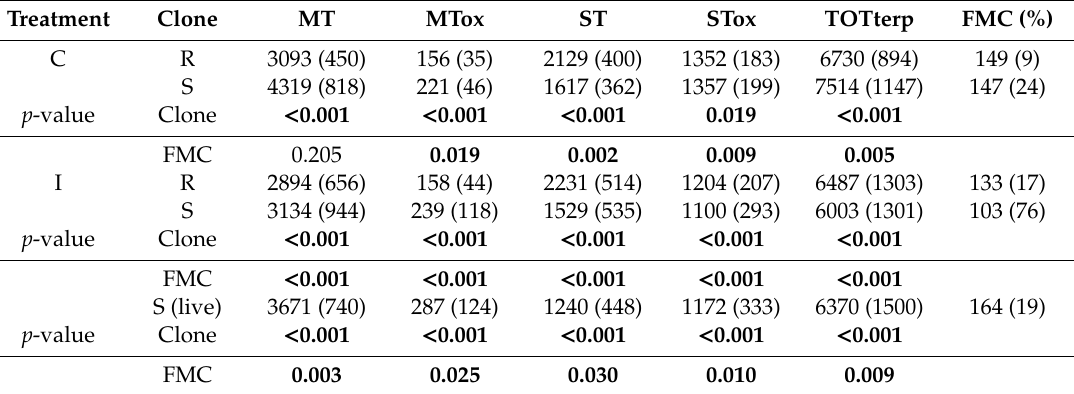
Table 2. GLMM on the concentration of terpenoids ( µ g / g) in the common cypress bark samples from the control (C) and infected (I) treatments, comparing the resistant (R) vs. susceptible (S) clones for the following variables: MT (monoterpenoids concentration), MTox (oxygenated monoterpenoids concentration), ST (sesquiterpenoids concentration), STox (oxygenated sesquiterpenoids concentration), TOTterp (total terpenoids concentration). The average and standard deviation (sd) for each variable are shown (N = 12). The p -value shows the significance of the fixed variables (clone, R vs. S) and covariable (FMC) predictors. Significant di ff erences ( > 95%) are highlighted in bold.